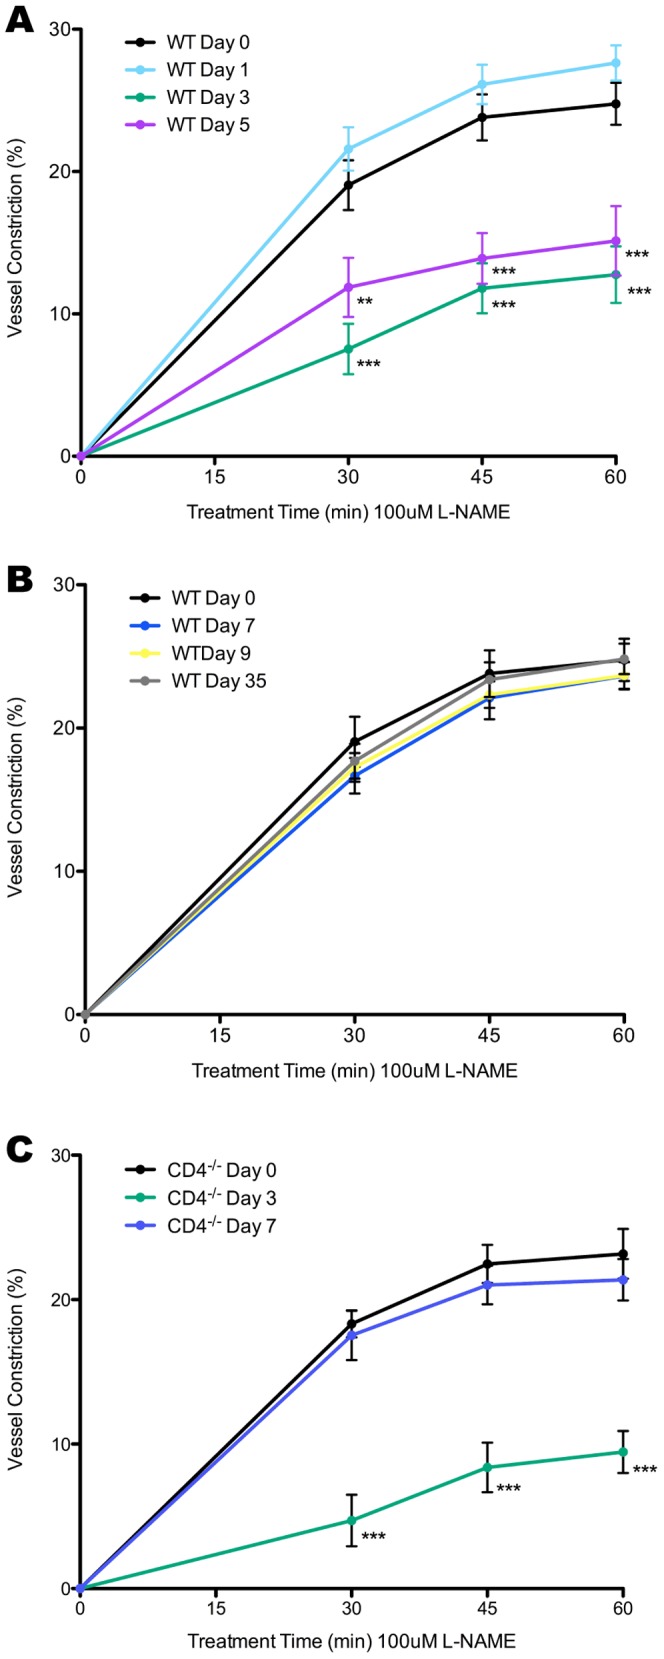
Percentage of vessel constriction in response to perfusion of 100μM L-NAME solution over the vessel preparation.Zero, one, three, and five days p.i. in C57 BL/6 mice (A). Zero, seven, nine, and thirty-five days p.i. in C57 BL/6 mice (B). Zero, three, and seven days p.i. in CD4-/- mice (C). Data represents percent vessel constriction in diameter ± SEM. *p<0.05 **p<0.01, and ***p<0.001.